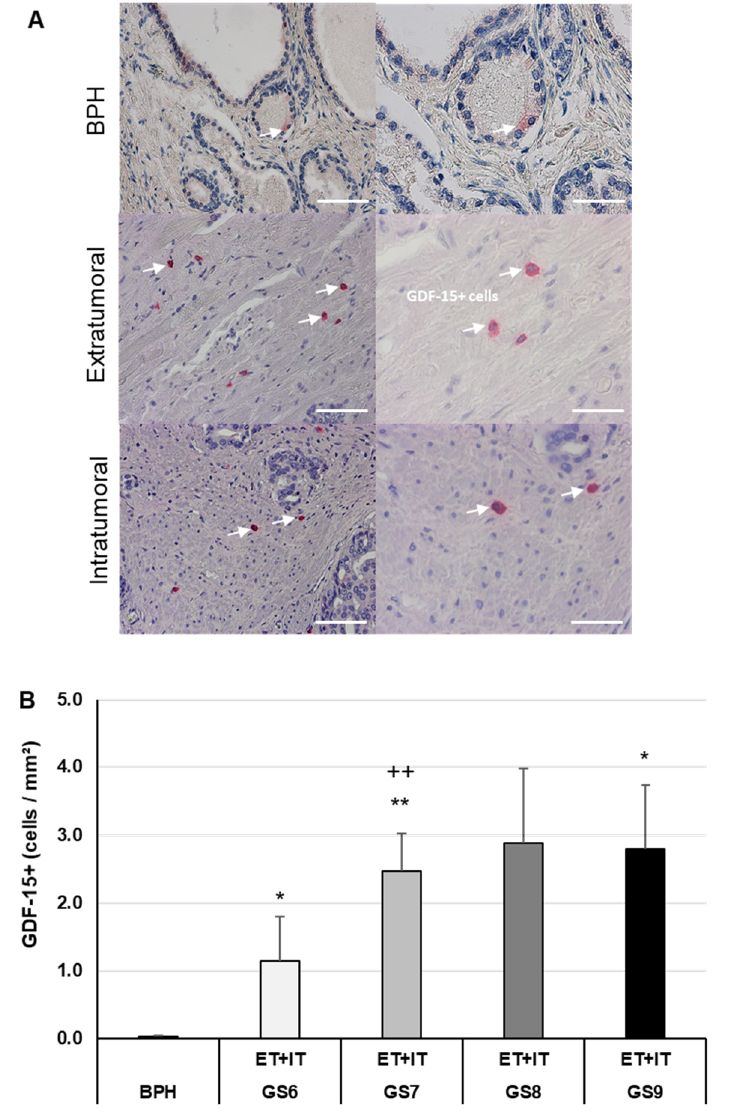
Figure 2. GDF-15 IHC of human BPH and PCa. ( A ) Representative images of BPH and extratumoral [ET] or intratumoral [IT] PCa regions. ( B ) Density of GDF-15+ cells in BPH and PCa (ET; IT) with different Gleason scores (GS). GDF-15+ cells are marked with white arrows. The data show means + SEM; significance: * p ≤ 0.05, ** p ≤ 0.01 vs. BPH; ++ p ≤ 0.01 vs. GS6. Scale bars: left column 200 µm, right column 100 µm.